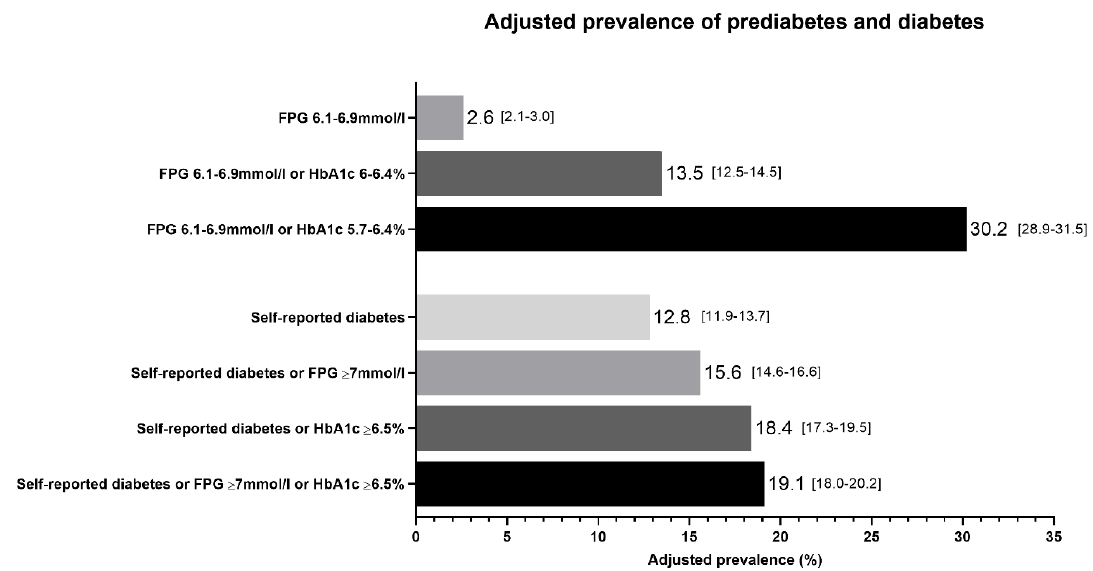
Figure 1. The adjusted prevalence of diabetes and prediabetes according to different diagnostic criteria ( n = 4937). KDEP Survey, adults in Kuwait aged 20 years or more. Prevalence adjusted for age, sex and nationality and presented with 95% confidence intervals. Table 2. Adjusted prevalence of prediabetes and diabetes in adults aged 20 years or more. Prediabetes Prevalence Diabetes